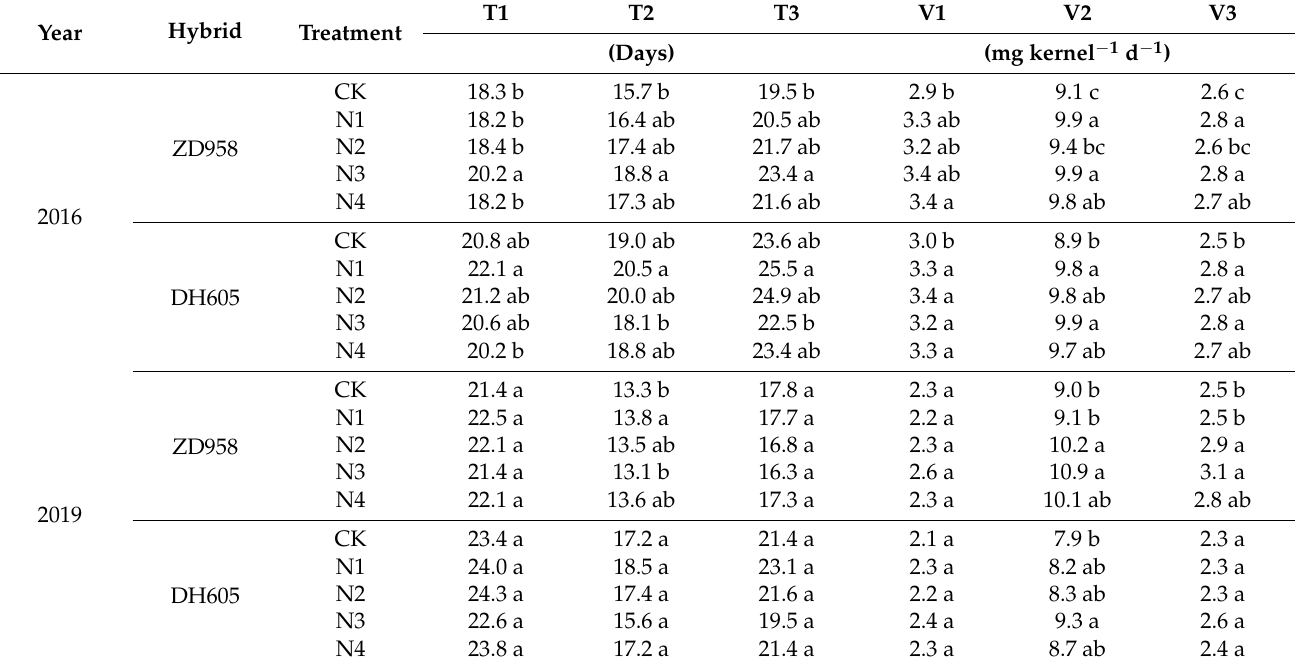
Table 3. Effects of N treatments on grain-filling parameters in summer